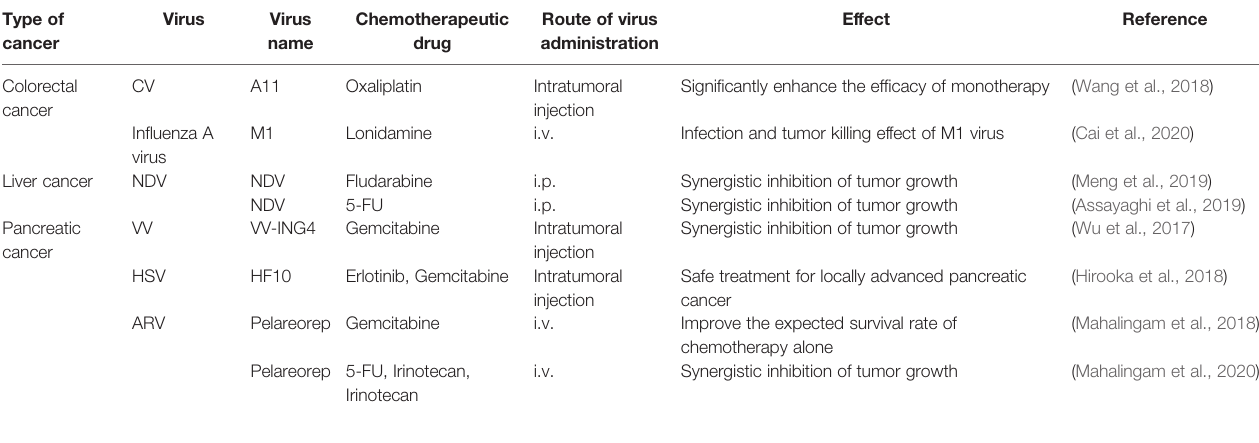
TABLE 2 | Oncolytic viruses combined with